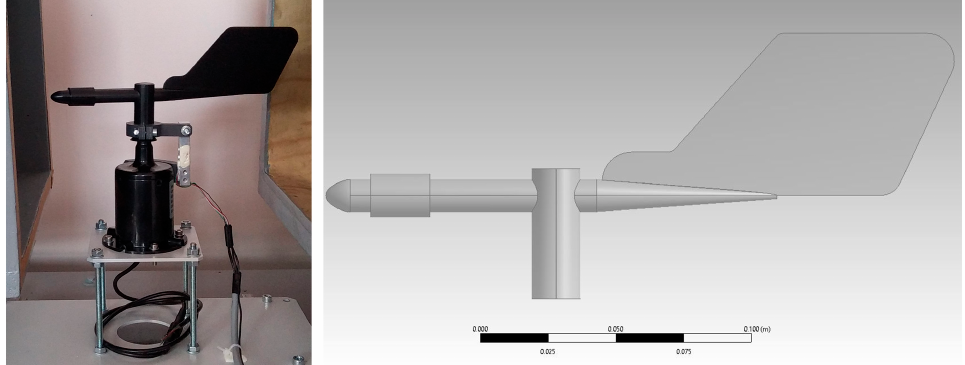
Figure 1. Photo of horizontal axis wind turbine weather vane and its 3D model.